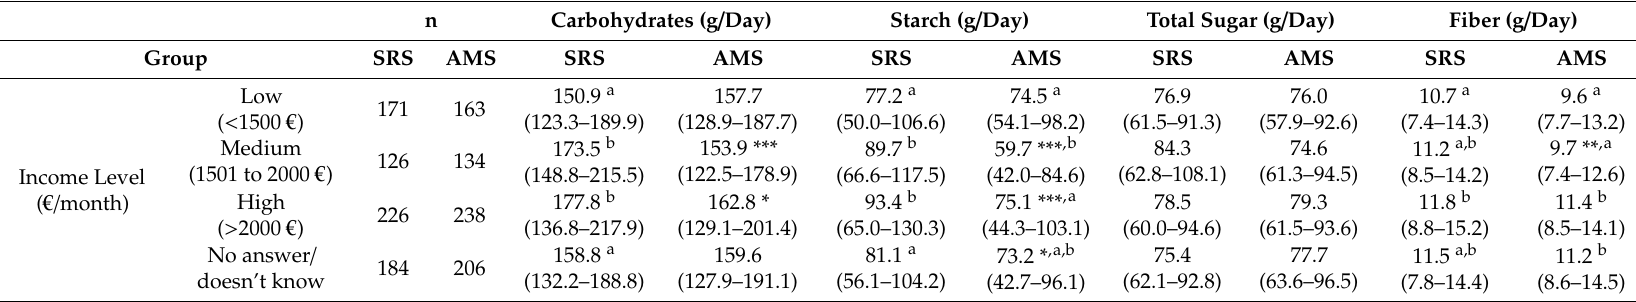
Table 7. Total carbohydrates, starch, total sugar, and fiber intake by monthly income levels from the Spanish Pediatric Population (EsNuPI) study in the Spanish Reference Cohort (SRS) and the Adapted Milk Consumers Cohort